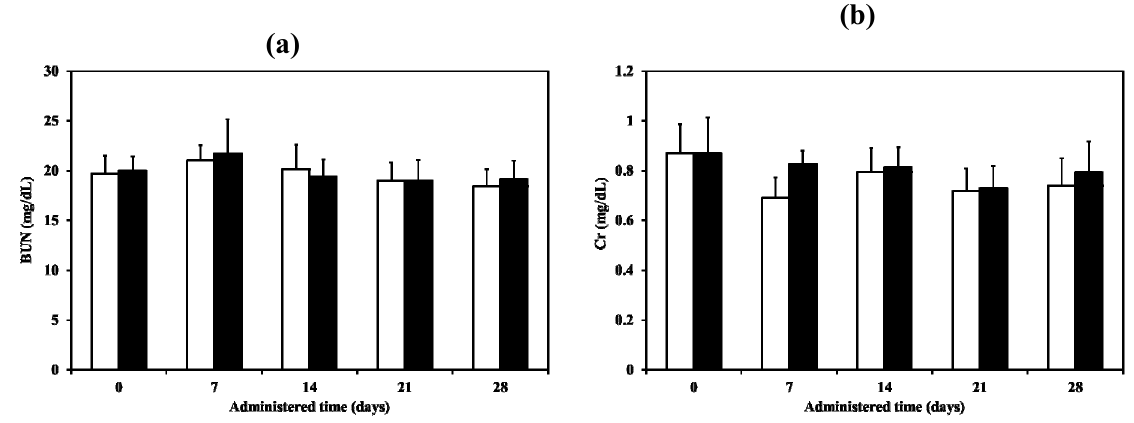
Figure 13. Serum biochemical parameters (( a ) BUN, ( b ) Cr, ( c ) ALT and ( d ) AST) of control (white column) and LEV-proliposome (black column) treated male Wistar rats in repeated dose toxicity study for 28